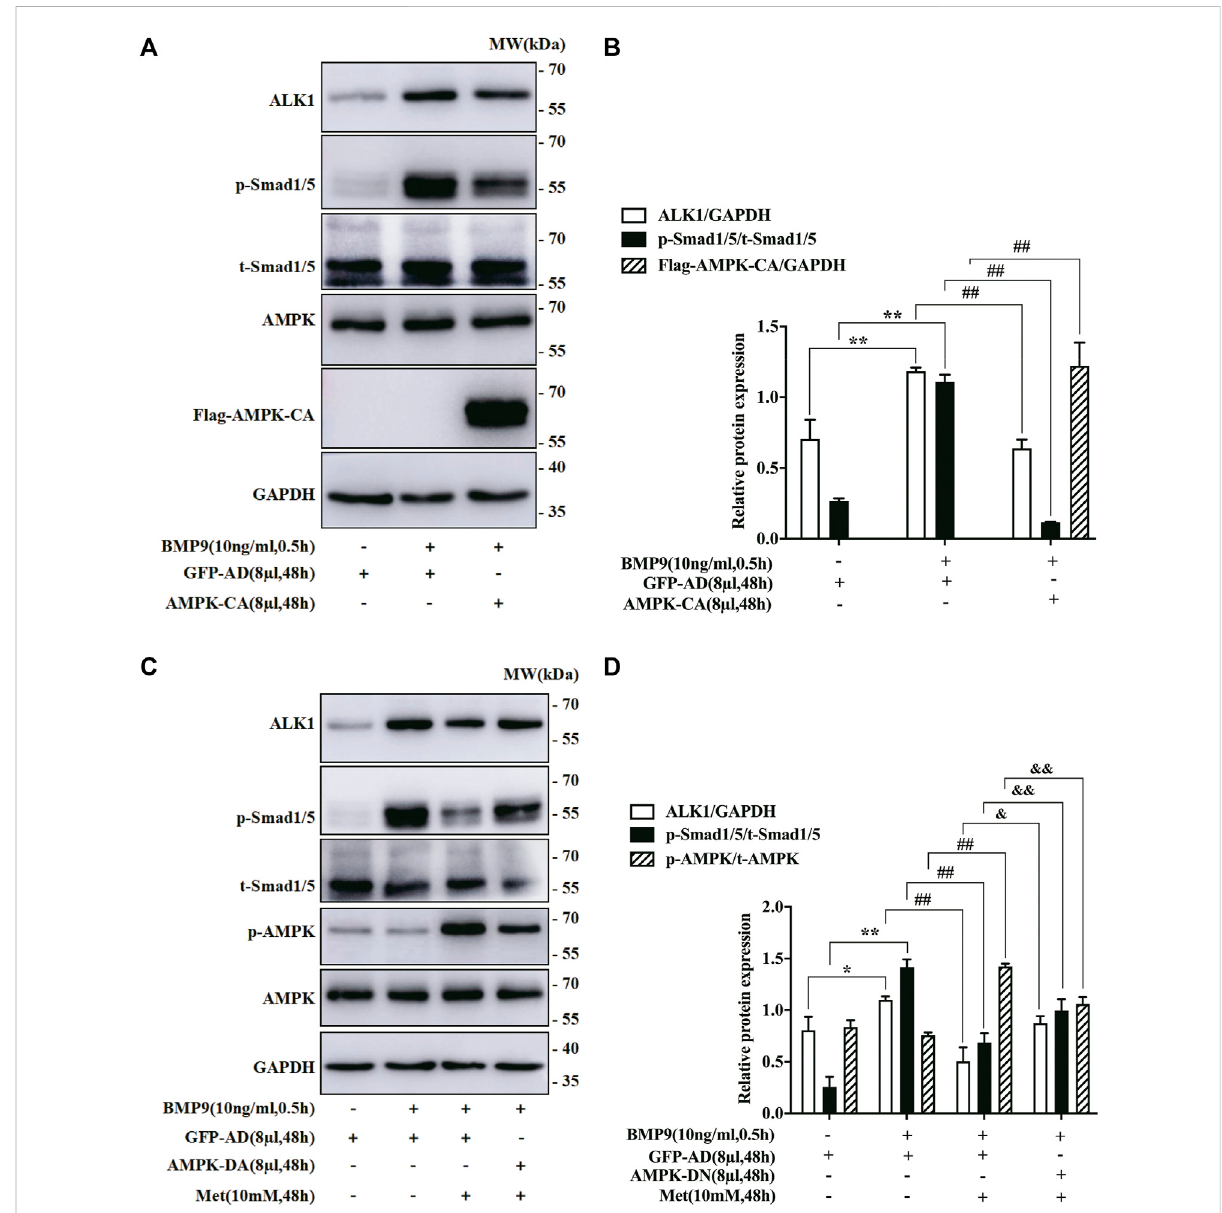
FIGURE 4 ImpactofAMPKMutantsontheexpressionofBMP9downstreamsignalmoleculesinHFL-1cells. (A,B) :Westernblotwasemployedtoexamine the effect of AMPK-CA on the expression of ALK1 and p-Smad1/5 ( n = 3). (C,D) : Western blot was applied to detect the effect of AMPK-DN on the expression of ALK1 and p-Smad1/5 ( n = 3). Data are presented as mean ± SD. * p < 0.05 and ** p < 0.01 versus only GFP-AD group; ## p < 0.01 versus GFP-AD with BMP9 group; & p < 0.05 and && p < 0.01 versus GFP-AD with BMP9 and metformin